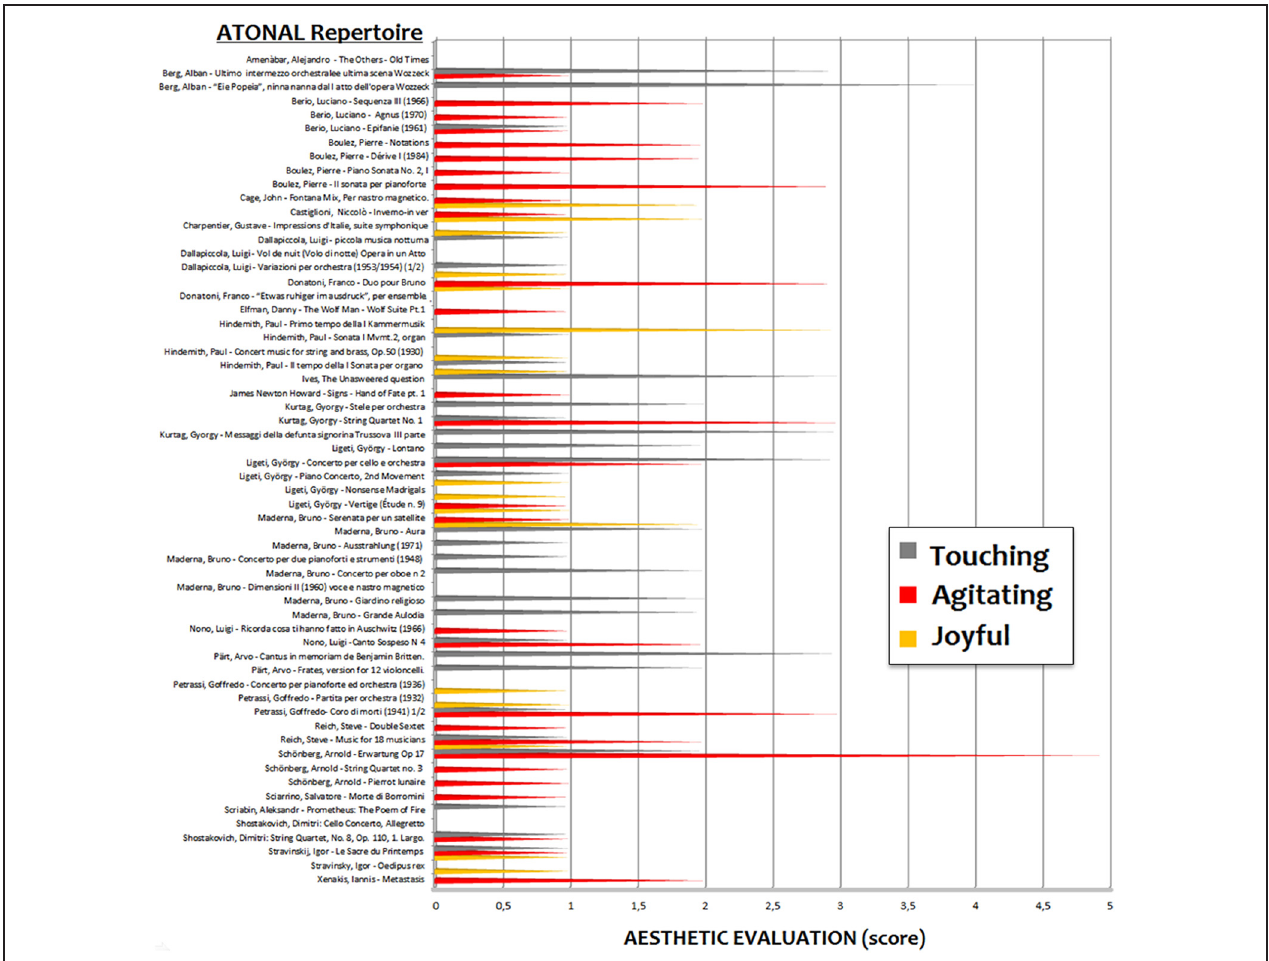
FIGURE 2 | Esthetic assessment of atonal artworks with respect to the three emotional categories (according to the evaluations of 20 conductors, composers, and conservatory professors).